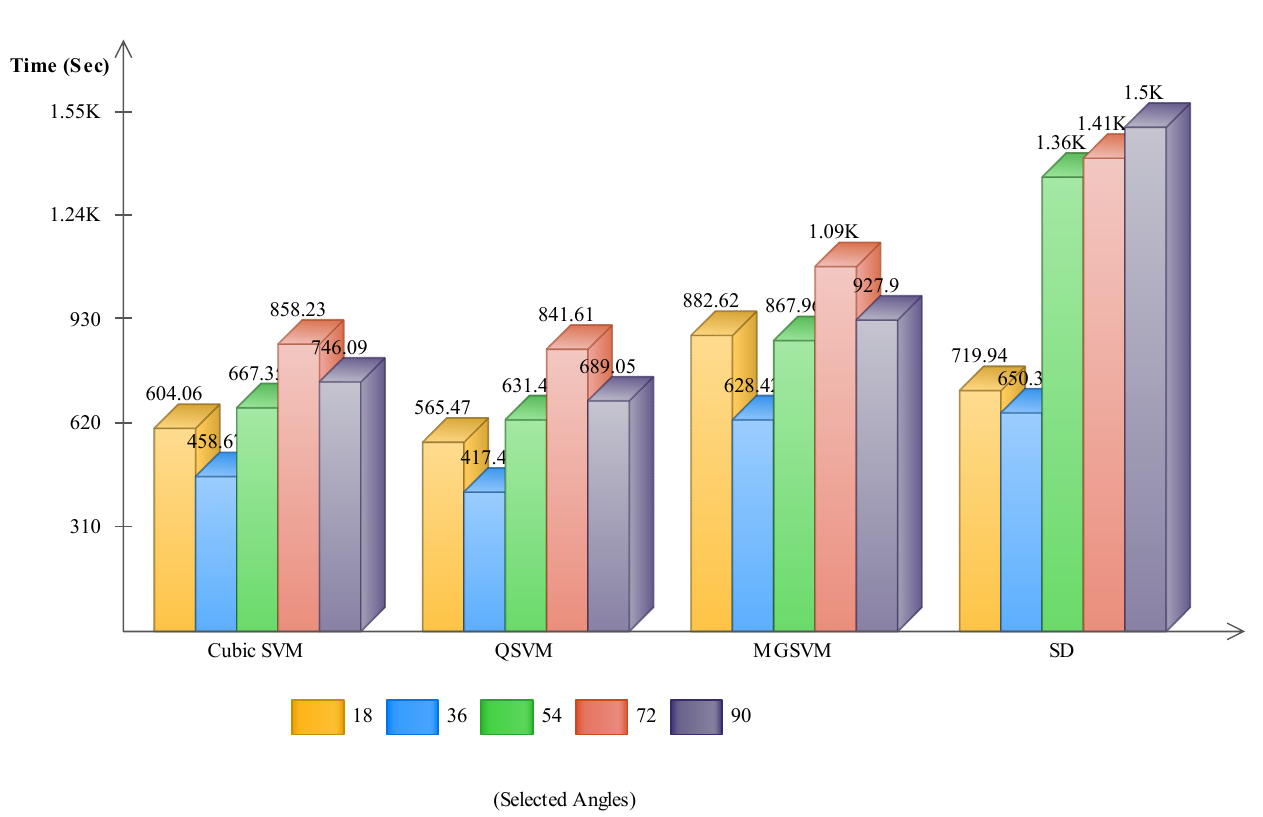
Figure 7. Computational time of the features fusion process using the augmented CASIA B dataset.